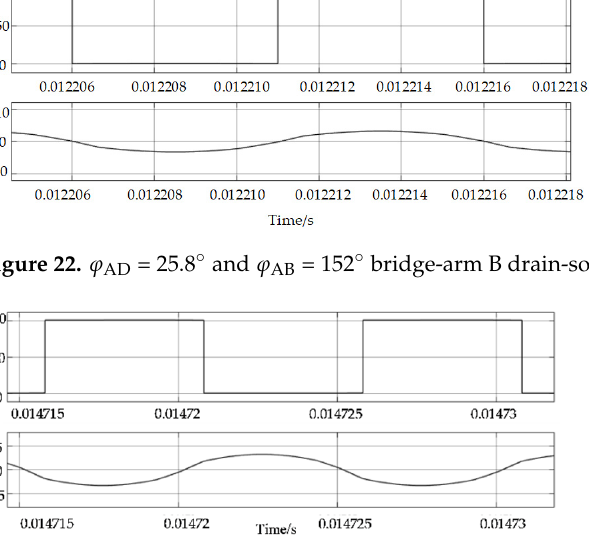
Figure 23. φ AD = 25.8° and φ AB = 152° bridge-arm C drain-source voltage and current waveforms. When full-arm ZVS is achieved, the A-arm current changes from negative to positive after the A-arm drain-source voltage drops to 0. The B-arm current changes from positive to negative after the B-arm drain-source voltage drops to 0. The C-arm current changes from negative to positive after the C-arm drain-source voltage drops to 0.